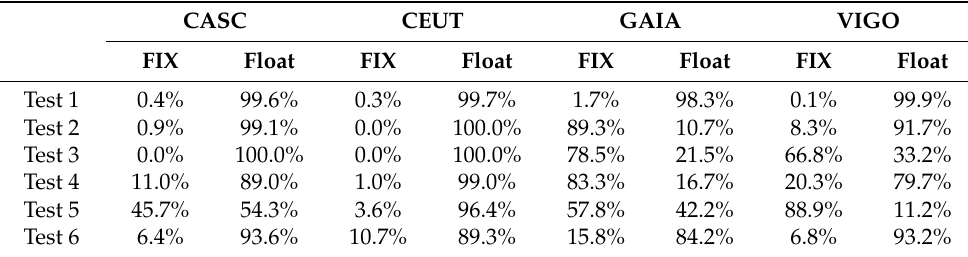
Table 6. Ambiguity resolution: Fix and Float ratio of solutions.